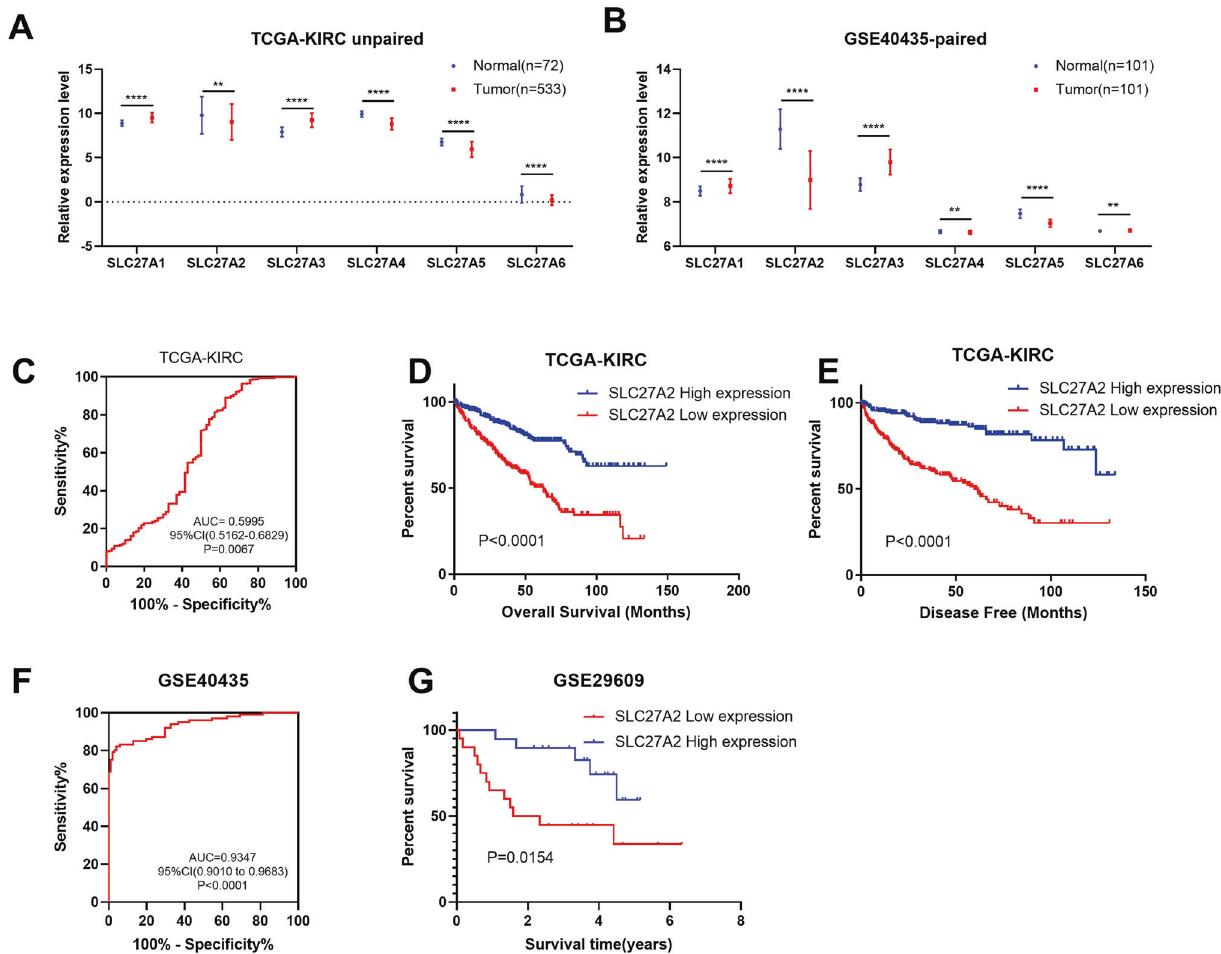
Fig. 1 SLC27A2 was downregulated in ccRCC and could act as a potential biomarker for ccRCC. A Expression pro fi les of SLC27As mRNA in ccRCC tissues ( n = 533) and neighboring normal tissues n = 72) were downloaded from TCGA-PRAD database. B Expression pro fi les of SLC27As mRNA in ccRCC tissues ( n = 101) and neighboring normal tissues ( n = 101) were downloaded from GSE40435-paired. C ROC curve of SLC27A2. D , E Kaplan – Meier curves of SLC27A2 expression. F ROC curve of SLC27A2 in GSE40435. G Kaplan – Meier curves of SLC27A2